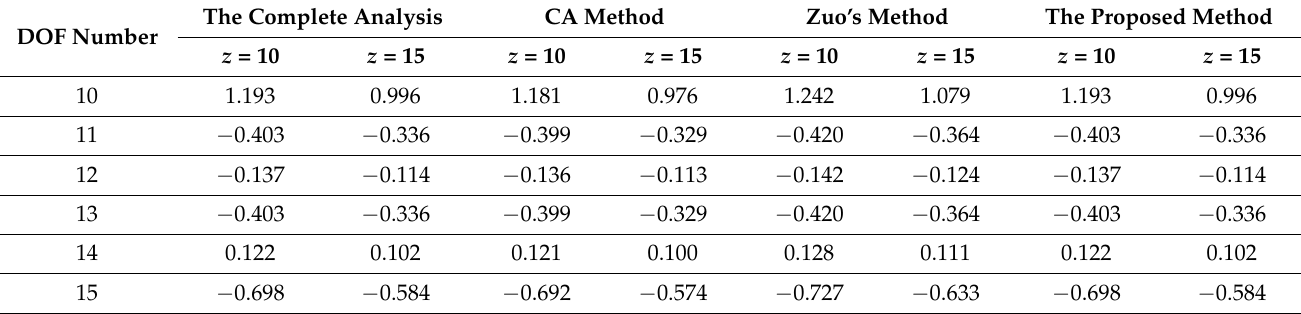
Table 9. Displacement sensitivities for modification type 2 when z = 10 and z = 15 ( × 10 − 5